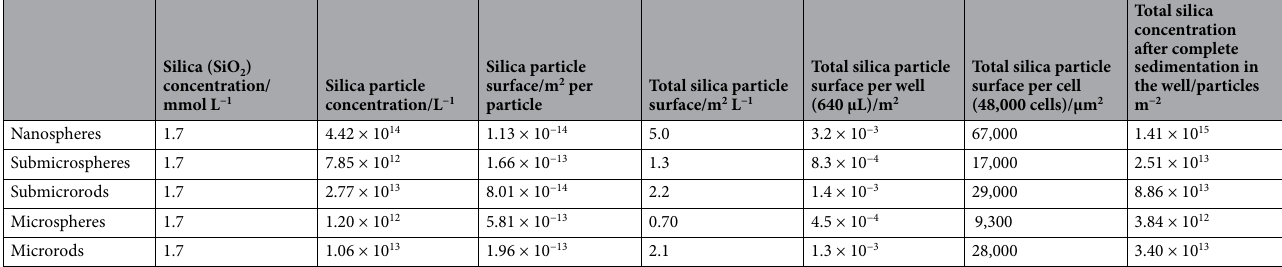
Table 2. Dose data for all cell culture studies with silica particles (100 µg mL −1 ) in a 24-well plate (2 cm 2 , 640 µL, 48,000 cells). As the cytotoxic effects of particles have been related to their total surface area, also with respect to the number of cells, the data were converted to different ratios (see discussion).